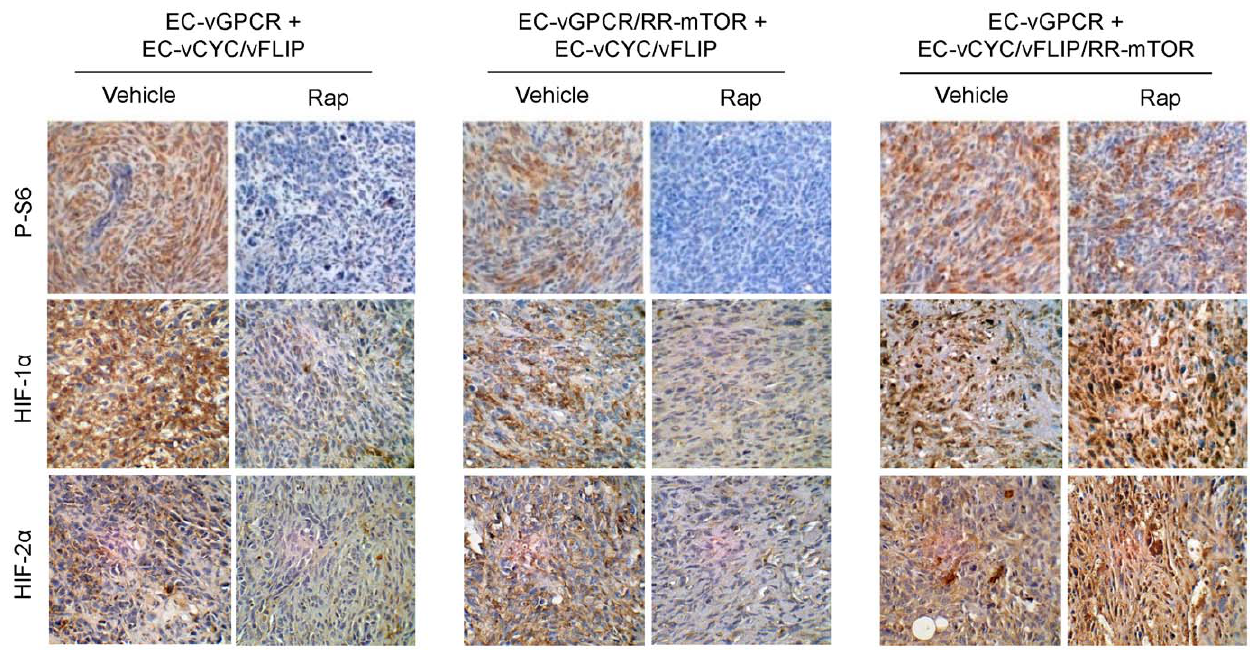
Figure 5. Paracrine activation of mTOR is required for HIF upregulation in vGPCR sarcomagenesis. Immunohistochemical staining with specific antibodies against phospho-S6 ribosomal protein, HIF-1 a and HIF-2 a of the allografts generated upon injection of EC-vGPCR (10%) + EC- vCYC/vFLIP (90%), EC-vGPCR/RR-mTOR (10%) + EC-vCYC/vFLIP (90%) or EC-vGPCR (10%) + EC-vCYC/vFLIP/RR-mTOR (90%), treated with vehicle or (10 mg/kg) Rapamycin.